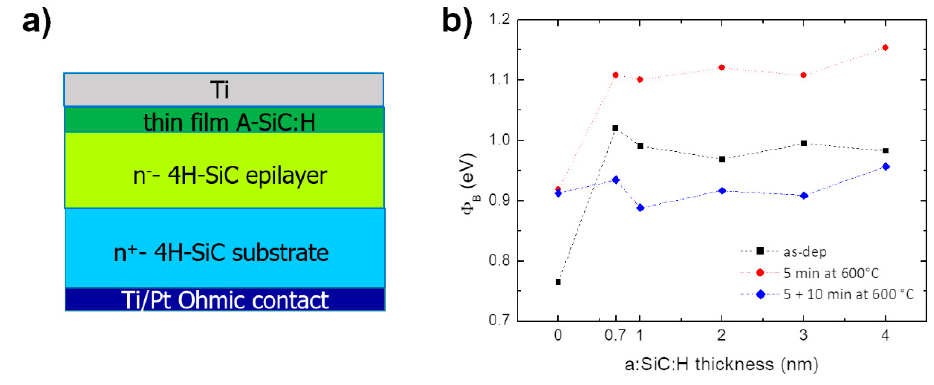
Figure 12. ( a ) Schematic view of a Ti/4H-SiC contact with an ultrathin amorphous SiC:H layer inserted between Ti and 4H-SiC. ( b ) Barrier height φ B for different thicknesses of the amorphous layer and duration of the annealing treatment. Panel ( b ) adapted with permission from Ref. [87]). Copyright 2021 Elsevier Ltd.